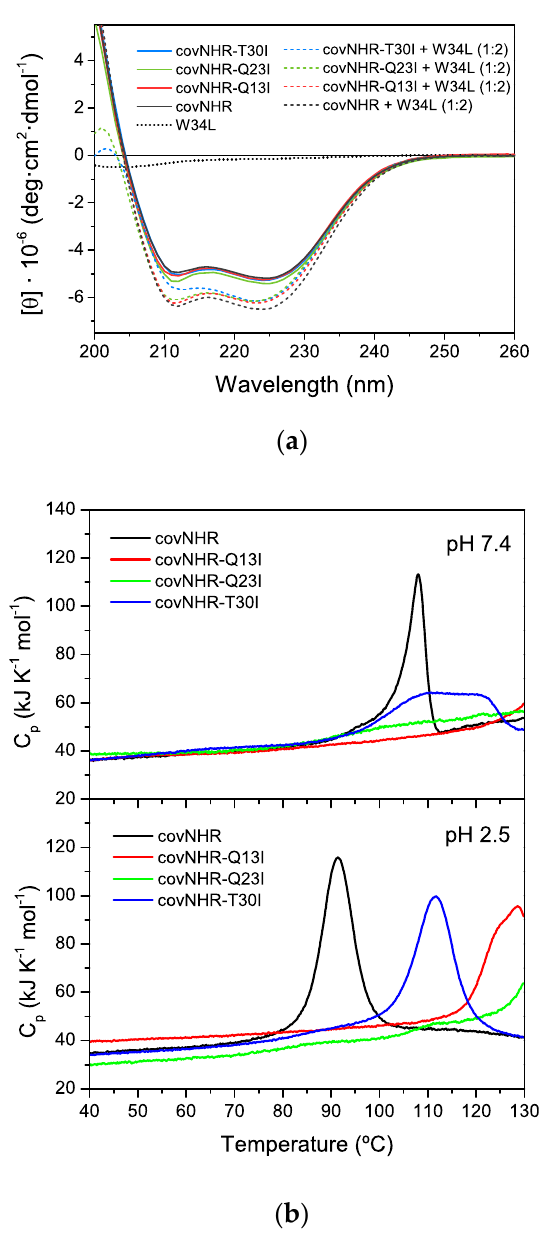
Figure 2. Structure and stability of the covNHR mutants. ( a ) Circular dichroism (CD) spectra of the free proteins and in complex with W34L peptide. The spectrum of the free peptide is also shown for reference. The spectra are normalized in ellipticity units per mole of protein. ( b ) Differential scanning calorimetry (DSC) thermograms of covNHR proteins at pH 2.5 and pH 7.4.